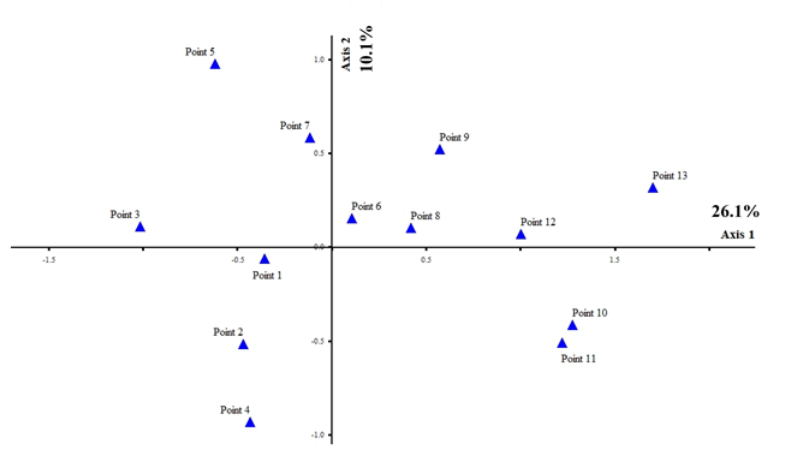
Figure 9 Similarity of algal composition by CCA ordination of the observed variance in environmental factors, across 13 sampling points in the rainy, winter, and summer seasons for subaerial green algae genus Trentepohlia . Axis 1 represents 26.1% and Axis 2 represents10.1% of the observed